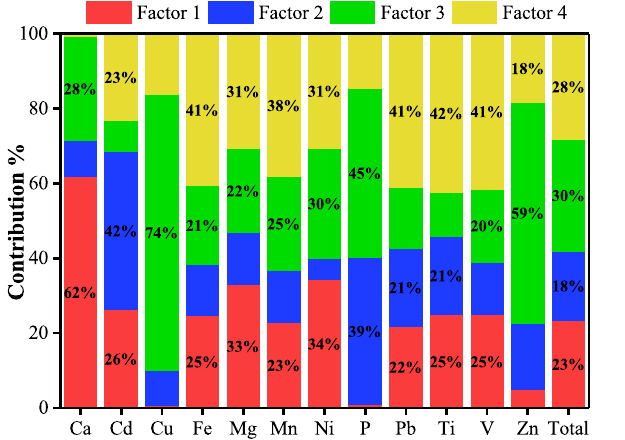
Figure 4. Source contributions analyzed by